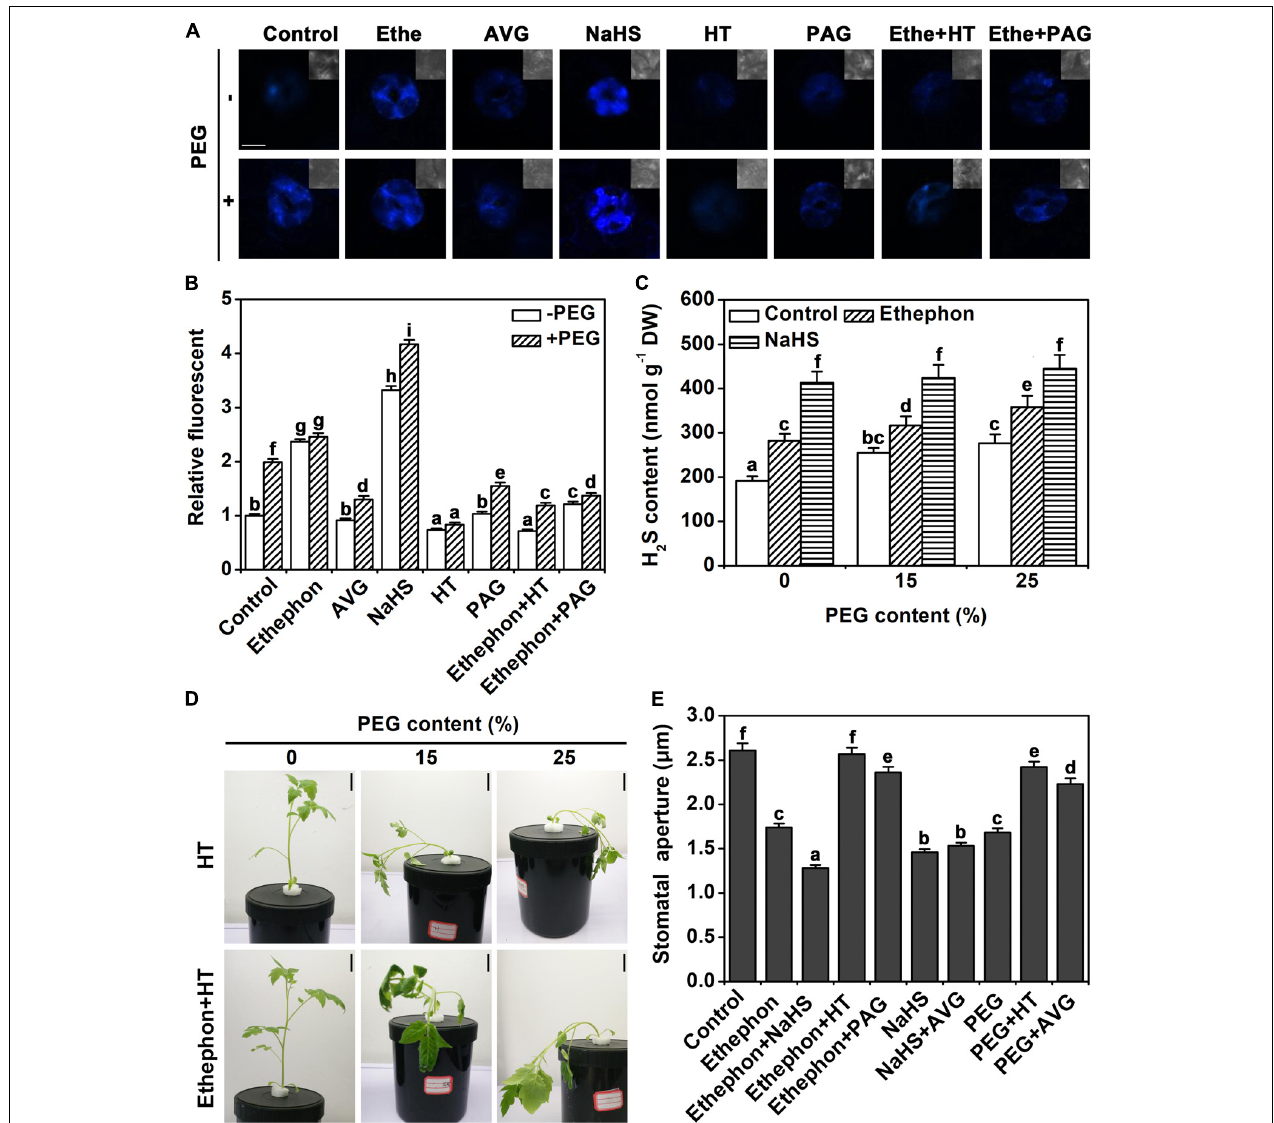
FIGURE 2 | Analysis of endogenous H 2 S content. (A) H 2 S AzMC fluorescence in guard cells (bar = 10 µ m). Two-week-old tomato seedlings were supplied with 25% PEG, 200 µ M NaHS, 200 µ M HT, 2 µ M PAG, 1.0 g/L Ethephon, and 200 µ M AVG for 6 h, and then endogenous H 2 S content was measured in guard cells. (B) Quantization of H 2 S AzMC fluorescence density. The data are mean values ± SE ( n = 20). (C) H 2 S content in leaves. Two-week-old tomato seedlings were supplied with 0–25% PEG, 200 µ M NaHS, and 1.0 for 6 h, and then endogenous H 2 S content was measured in leaves. (D) Photographs of tomato seedlings. Two-week-old tomato seedlings were supplied with between 0 and 25% PEG, 200 µ M HT and 1.0 g/L ethephon for 3 days, and then the phenotype was observed (Bar = 2 cm). (E) Stomatal aperture assays. Two-week-old tomato seedlings were supplied with 25% PEG, 200 µ M NaHS, 200 µ M HT, 2 µ M PAG, 1.0 g/L Ethephon and 200 µ M AVG for 6 h, and then stomatal aperture was measured. Mean values ± SE are calculated from three replicates. Within each set of experiments, bars with different letters are significant different (Duncan’s multiple range tests, P <